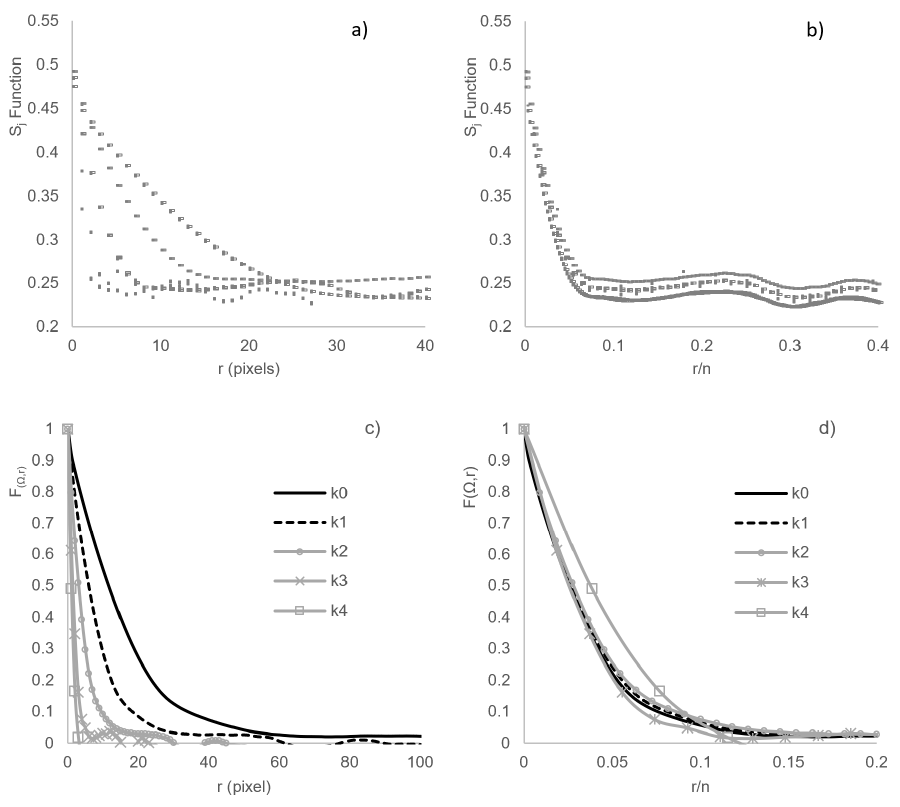
average for all ω realizations of every configuration of ((cid:3078),(cid:3045))